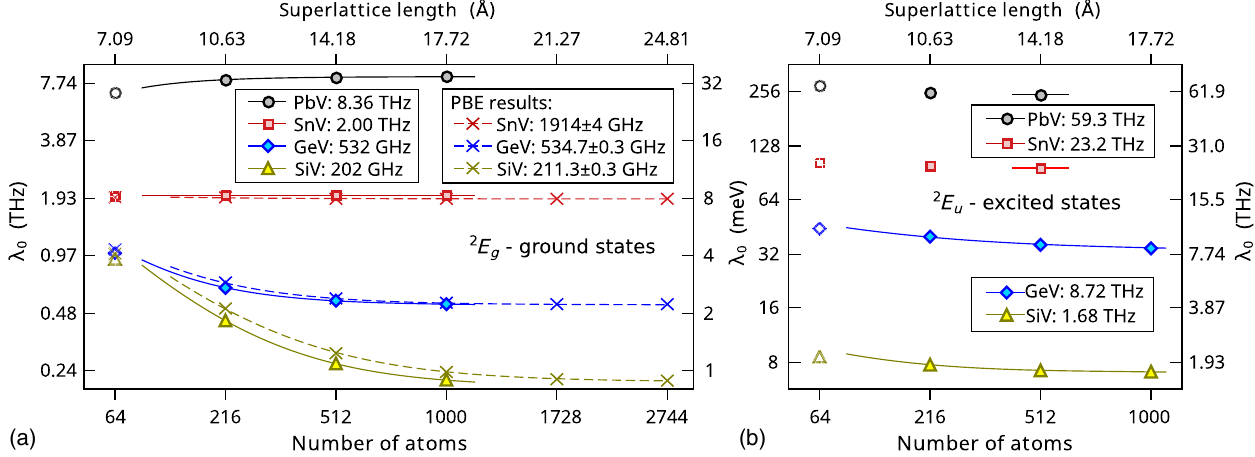
FIG. 7. Calculated spin-orbit energies with HSE06 DFT functional as a function of the size of the supercell within Γ -point ground and (b) 2 E excited state. The converged values are given in the label boxes. We show the approximation for (a) 2 E g u ground state, too. The 5 data points for PBE yield a standard computationally less expensive PBE results for giant supercells for 2 E g error for the fitting. The small standard error in these calculations supports the exponential decay for HS06 data